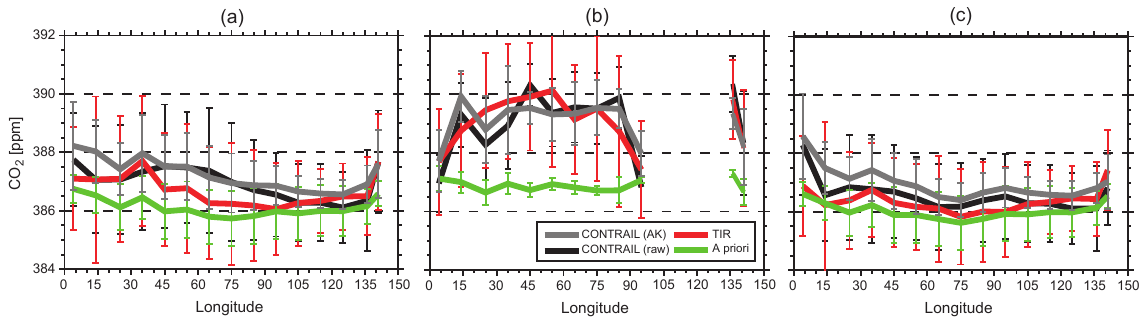
Figure 6. Same as Fig. 5 but for flights between Tokyo and Europe (NRT_DME_AMS) in winter (JF). (a) All of the data, (b) only data in the troposphere, and (c) only data in the stratosphere. See the text for the classification of tropospheric and stratospheric data.